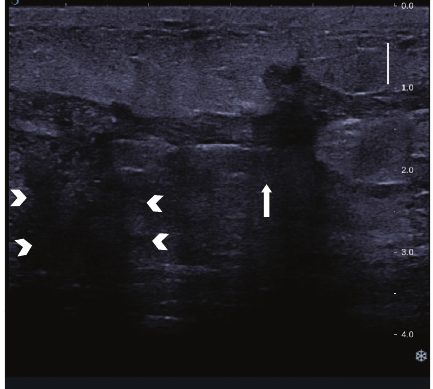
Figure 5: Sinus tracts. Linear sinus tracts can be seen tracking away from the abscess into surrounding tissues.